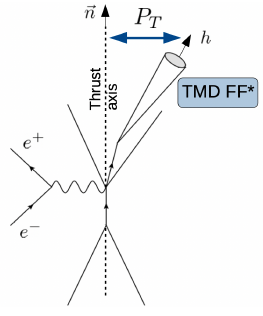
Figure 2: Pictorial representation of an e + e − → hX scattering